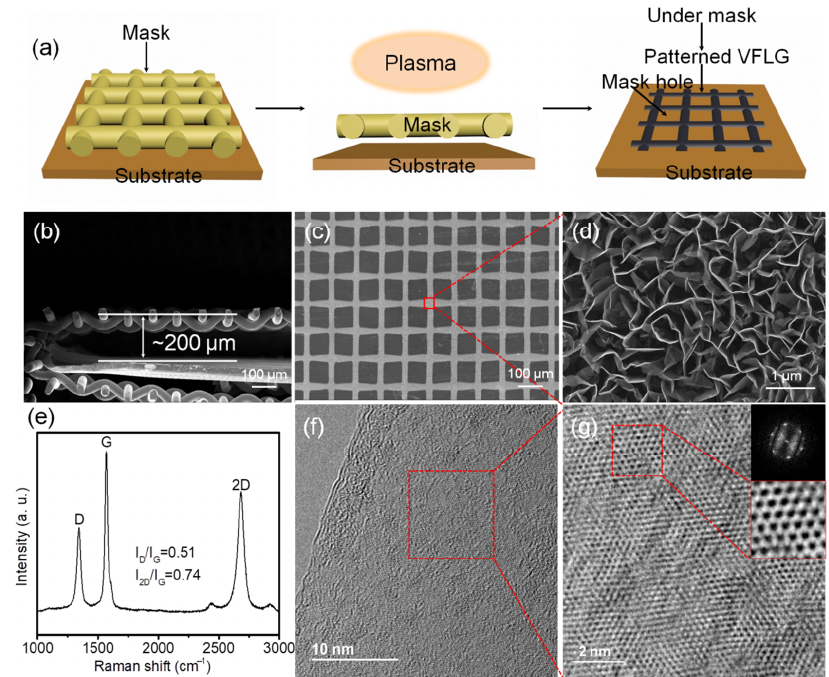
Figure 1. ( a ) Schematic diagrams of HCVFLG preparation. ( b ) SEM image of Cu mask template covered substrate. ( c ) SEM image of HCVFLG and ( d ) high magnification SEM image of the VFLG. Raman spectra of HCVFLG ( e ) and TEM image of HCVFLG ( f ), ( g ) is magnification of the red rec- tangle in ( f ). Inset of ( g ) is diffraction pattern image and magnification image of the red rectangle area.